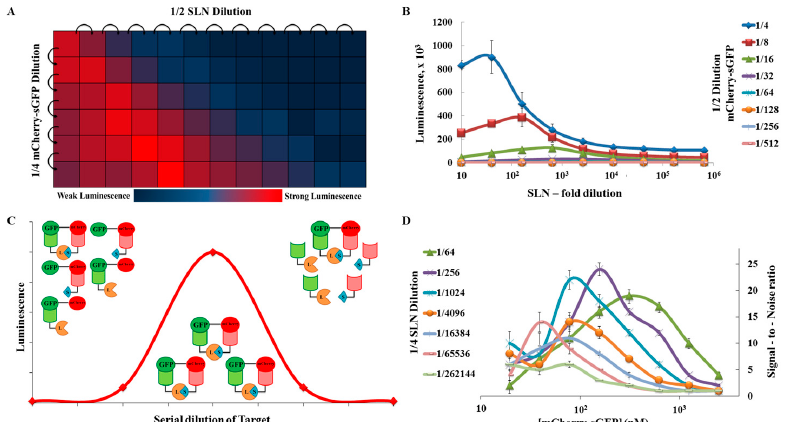
Figure 3. Detection limit studies using a direct approach. ( A ): Heat-map of the ‘hook’ effect; the ‘hook’ effect transition is seen when we plot the luminescence values of SLN and target dilution as a heat-map. Here the highest luminescence is plotted in red and weaker luminescence transits towards blue; ( B ): Graphical representation of the ‘hook’ effect as seen with the mCherry–sGFP tandem